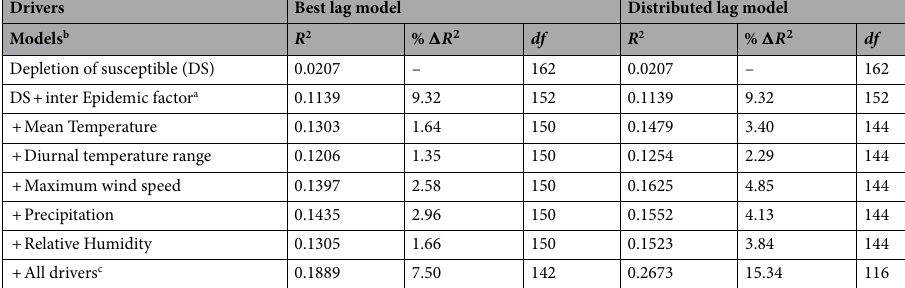
Table 1. Proportions of the variance of the effective reproduction number explained by the meteorological drivers, from models on pre-defined RSV epidemics with a maximum duration of 7 weeks to both side of peaks for RSV infections in Singapore from 2005 through 2015. We used the 5-daysmoving average window to smooth daily hospitalization data for best lag and distributed lag model with lags of 0–14 days. a Basic model: factors affecting R t include depletion of susceptibles, inter-epidemic factors. b Improved models include the basic model for R t plus the respective drivers. c Improved model includes the drivers: mean temperature, diurnal temperature range, maximum Wind Speed, Precipitation and Relative Humidity (statistically 2 significant and free from multicollinearity). % (cid:31) R measured the change in the explained variance (of total variance) from the model in comparison to the basic model.